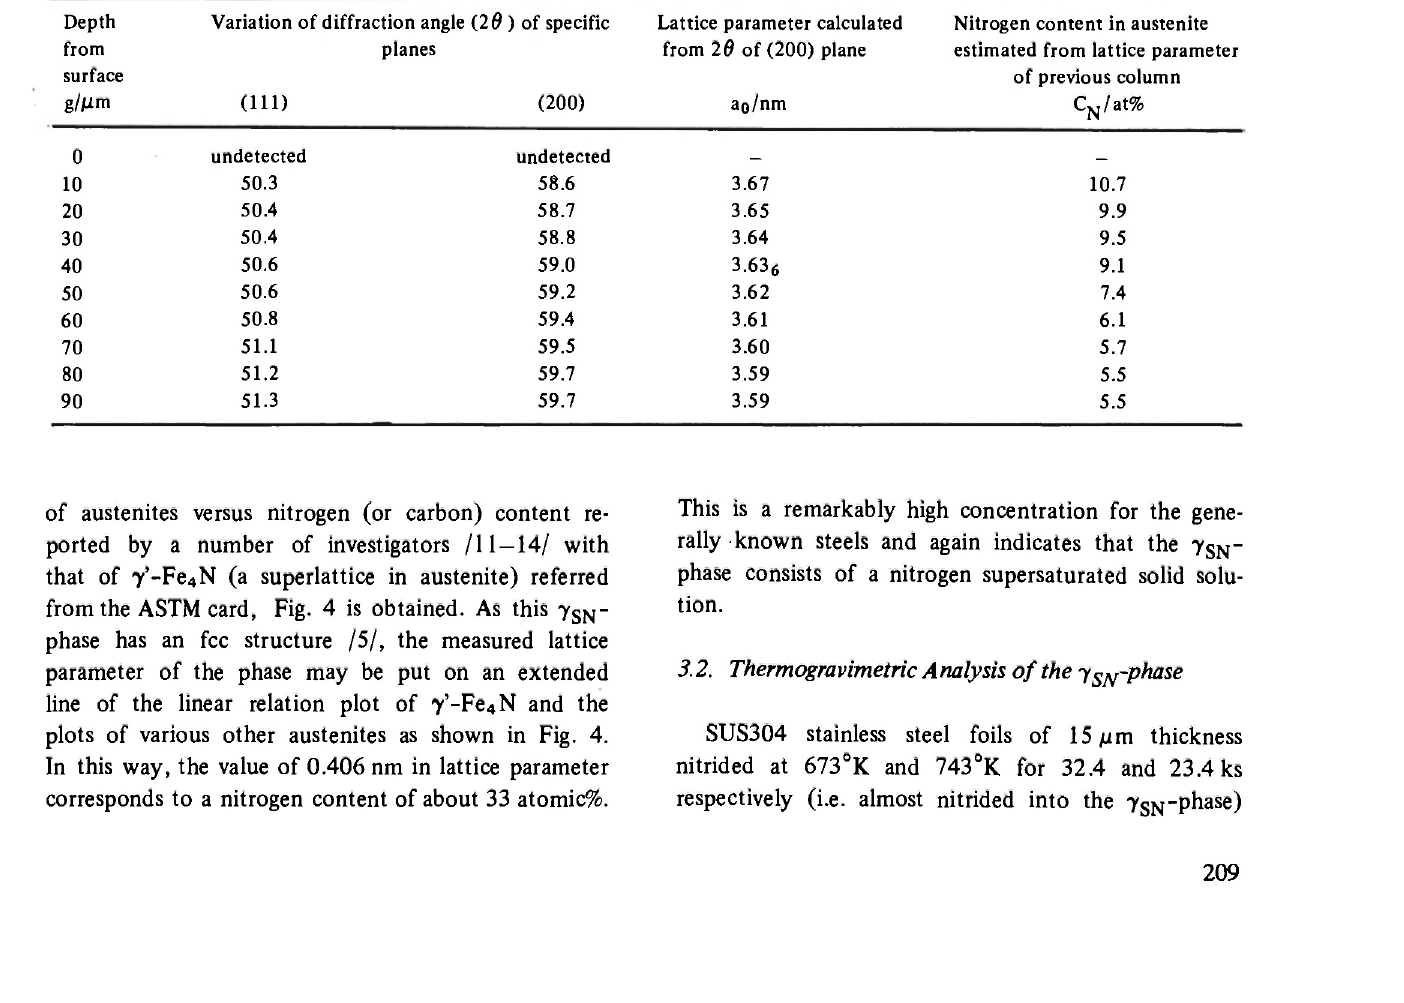
Variation of lattice parameter of austenite in nitrided layer of SUS304 stainless steel nitrided at 873 Κ for 10.8 ks in ammonia gas and of nitrogen content in the austenite at various depth from the surface Depth Variation of diffraction angle (20 ) of specific Lattice parameter calculated Nitrogen content in austenite from planes from 20 of (200) plane estimated from lattice parameter surface of previous column